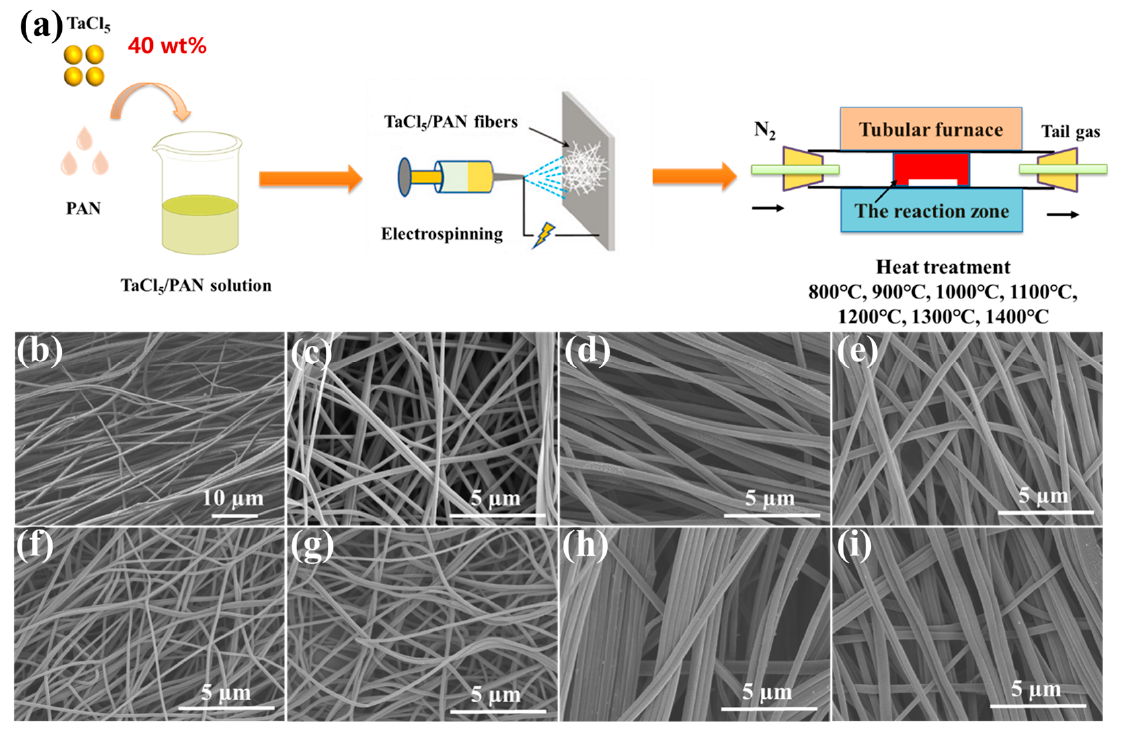
Figure 1. ( a ) Schematic diagram of preparation of electrospun TaC/C composite fibers at different carbonization temperatures. ( b ) SEM images of electrospun TaCl 5 /PAN fibers with 40 wt% TaCl 5 . SEM images of TaC/C composite fibers were prepared at different carbonization temperatures ( c ) 800 °C; ( d ) 900 °C; ( e ) 1000 °C; ( f ) 1100 °C; ( g ) 1200 °C; ( h ) 1300 °C and ( i ) 1400 °C.